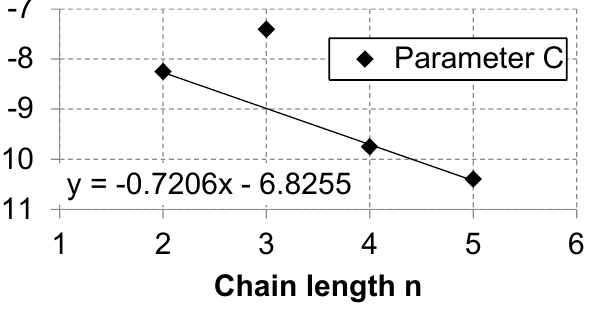
Figure A5. Linear regression of correlation parameter B of the vapor pressure equation (Equation (8)) for OME 2–5 (data given by Boyd [77]).